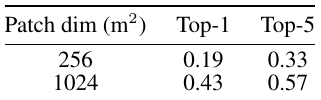
Table 1. Ground sample distance study for 2m localization tasks with patch dimension of 1024 m 2 and batch size of 256.